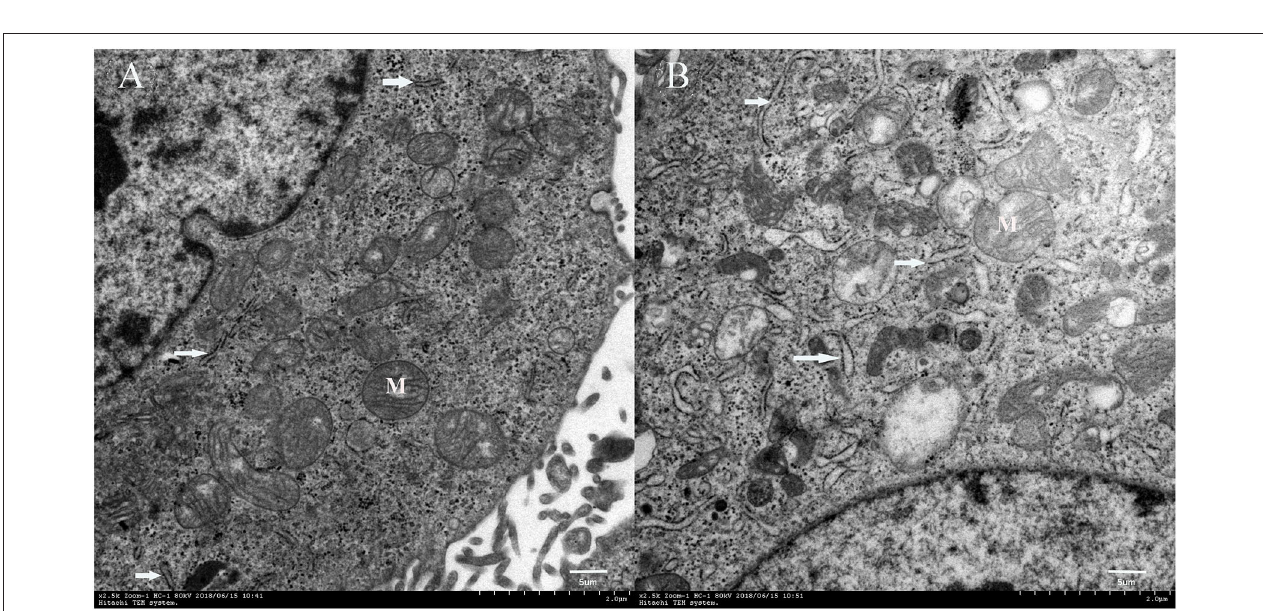
FIGURE 4 | Transmission electron microscopy images of FD-LSC-1 cells cultured in the AGL (A) and DUGL (B) (at 2,500 × magnification). White arrows, endoplasmic reticulum; M, mitochondria; AGL, above-ground laboratory; DUGL, deep underground laboratory.